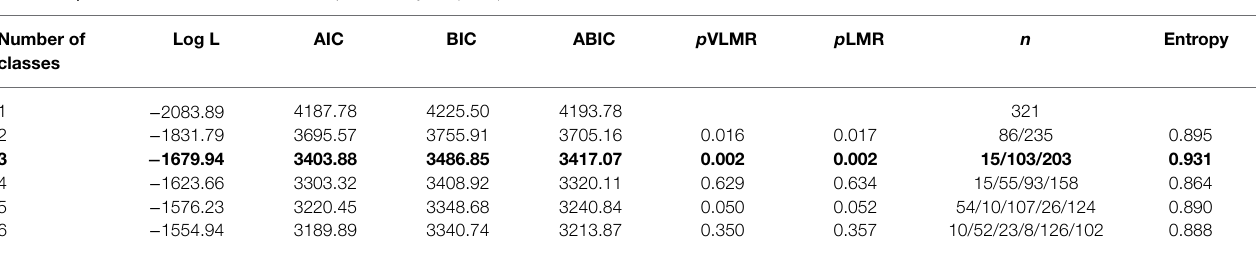
TABLE 2 | Fit indices for the series of latent profile analyses